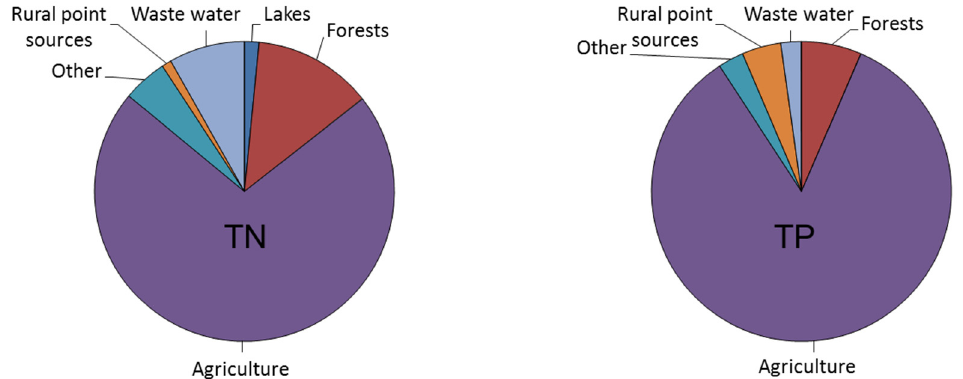
Figure 6. Long-term source apportionment for total N and total P in the Söderköpingsån River calculated with the HYPE-model.